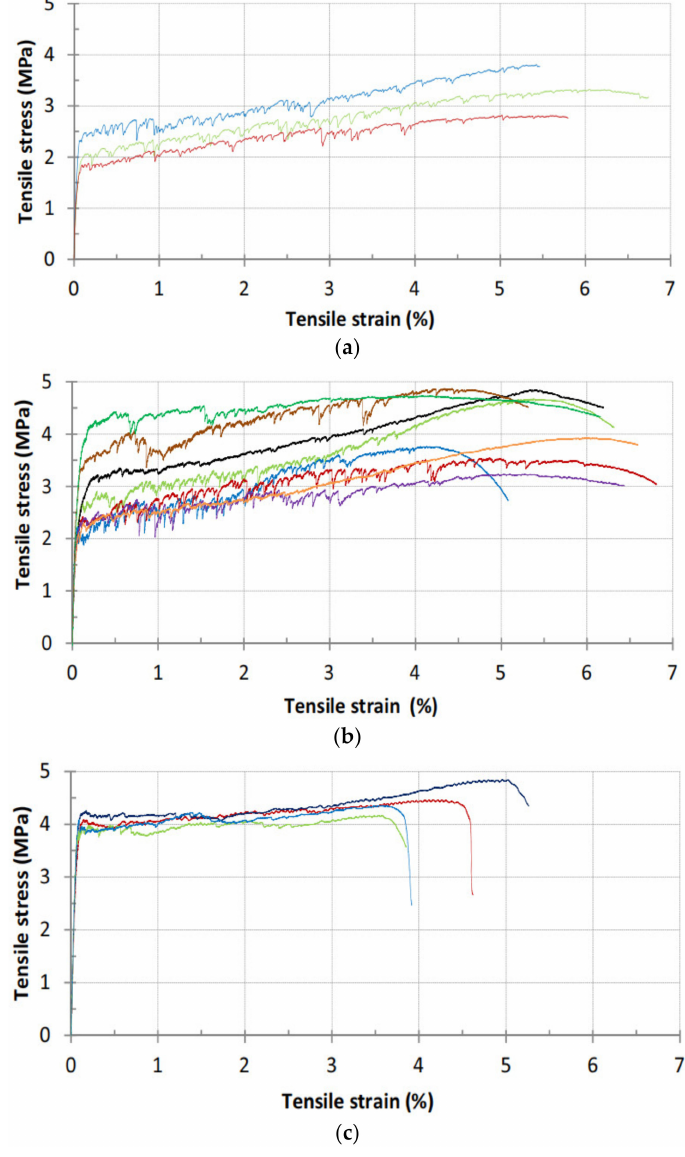
Figure 2. Tensile stress–strain responses of FOPG [67]. ( a ) Heat-cured FOPG (PE-H), ( b ) Ambient- temperature-cured FOPG (PE-A), ( c ) Ambient-temperature-cured FOPG (PVA-A). Adapted with permission from [67], copyright 2017